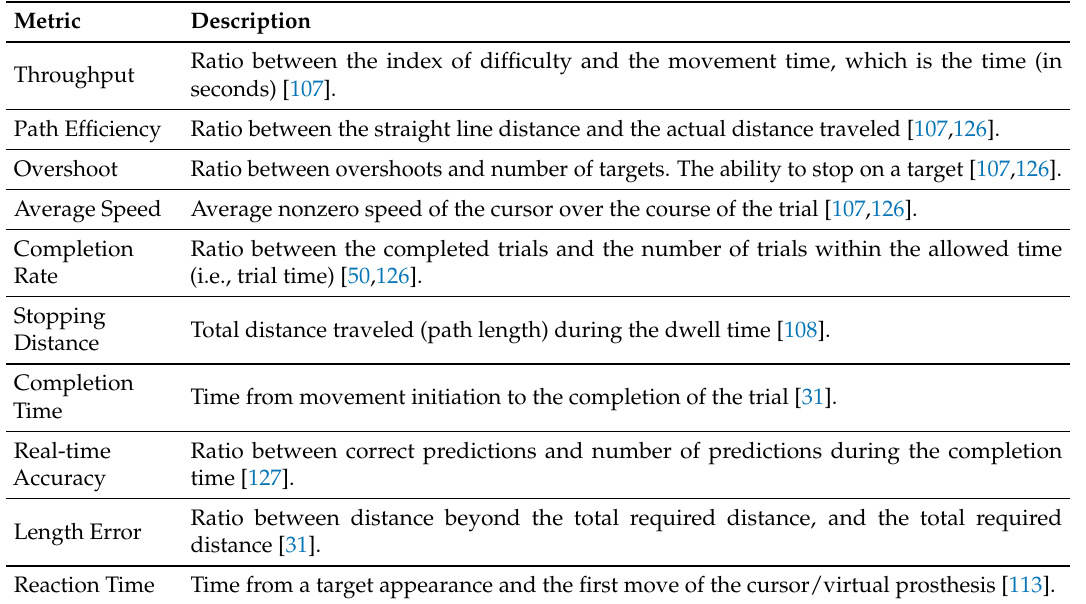
Table 14. Metrics of the target achievement test used by the nine HGR